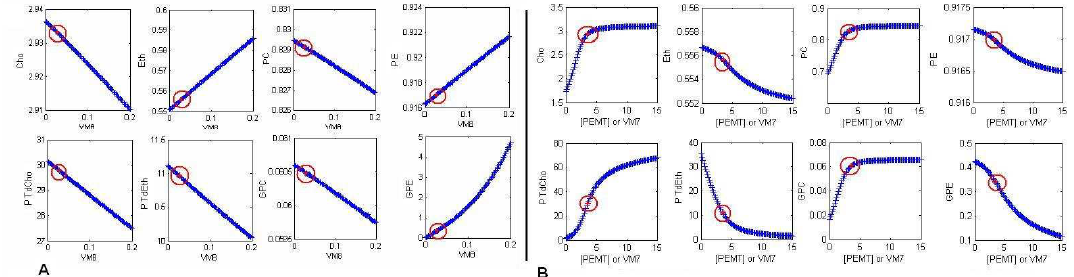
Figure 3: Steady State Concentration vs. Enzyme Concentration. A: Change of steady state point for the reaction of PtdEth and GPE. On each of these diagrams, each point (VM, ˜ Xi ) corresponds to a concentration of the reactant X i at the steady state. B: Change of steady state point for the reaction of PtdEth and PtdCho. The red point in each of these diagrams is associated to the concentration at the steady state of the experimental values. Concentration values are given in µmol.g − 1